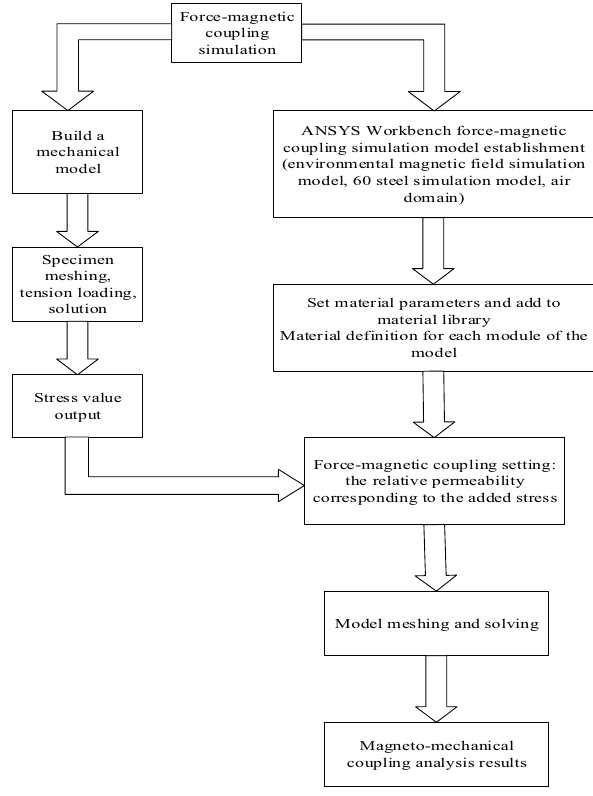
Fig. 3 Simulation flow chart of force-magnetic